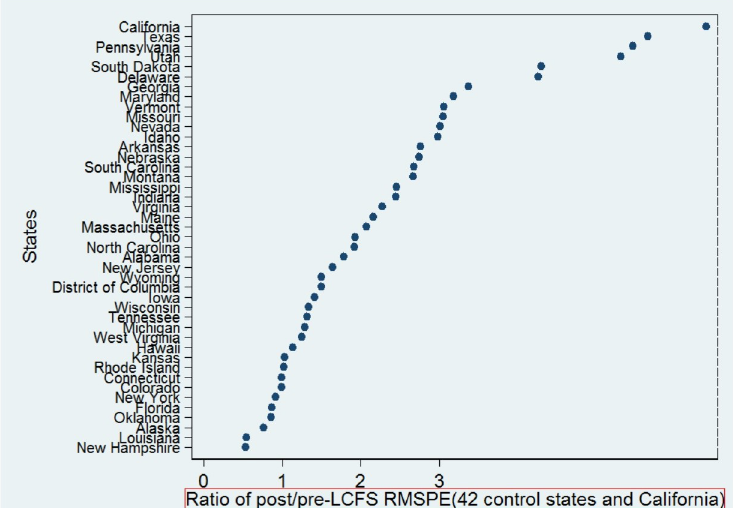
Fig 4. The post-pre RMSPE test of the synthetic control estimation to measure the effect of the LCFS on emissions.